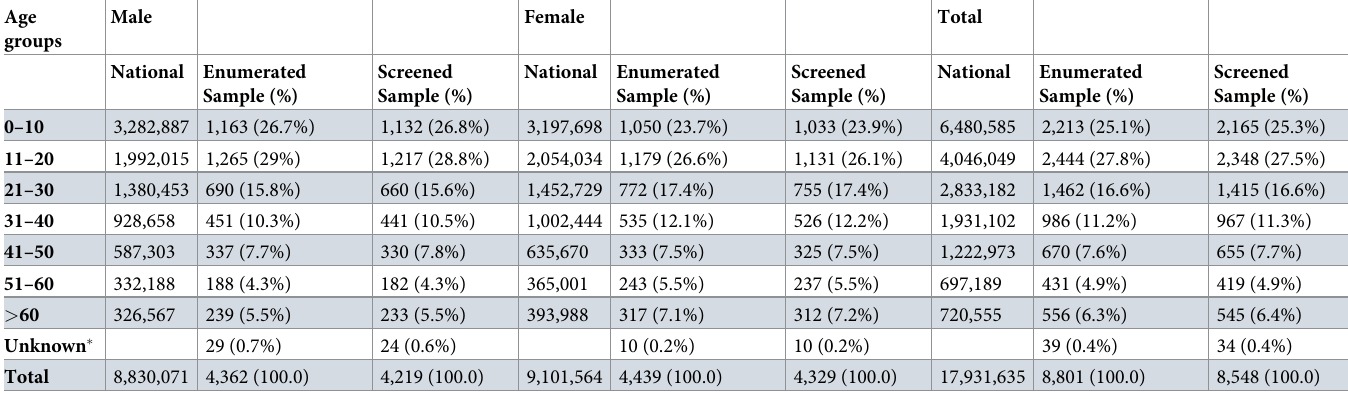
Table 3. Age and gender composition of national and screened sample